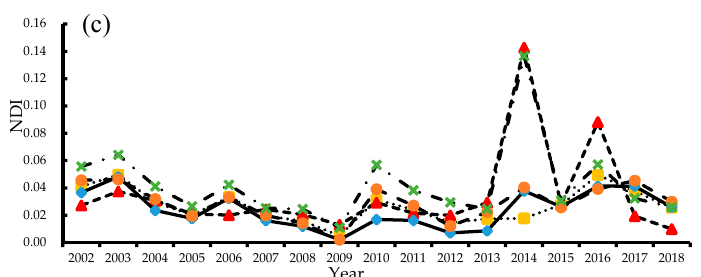
Figure 4. TNL data comparison under different correction methods, Nationwide ( ■ ), Northeastern ( ▲ ), Eastern ( ◆ ), Central ( ● ), Western (×); ( a ) uncorrected; ( b ) corrected in this article; ( c ) reference correction method.